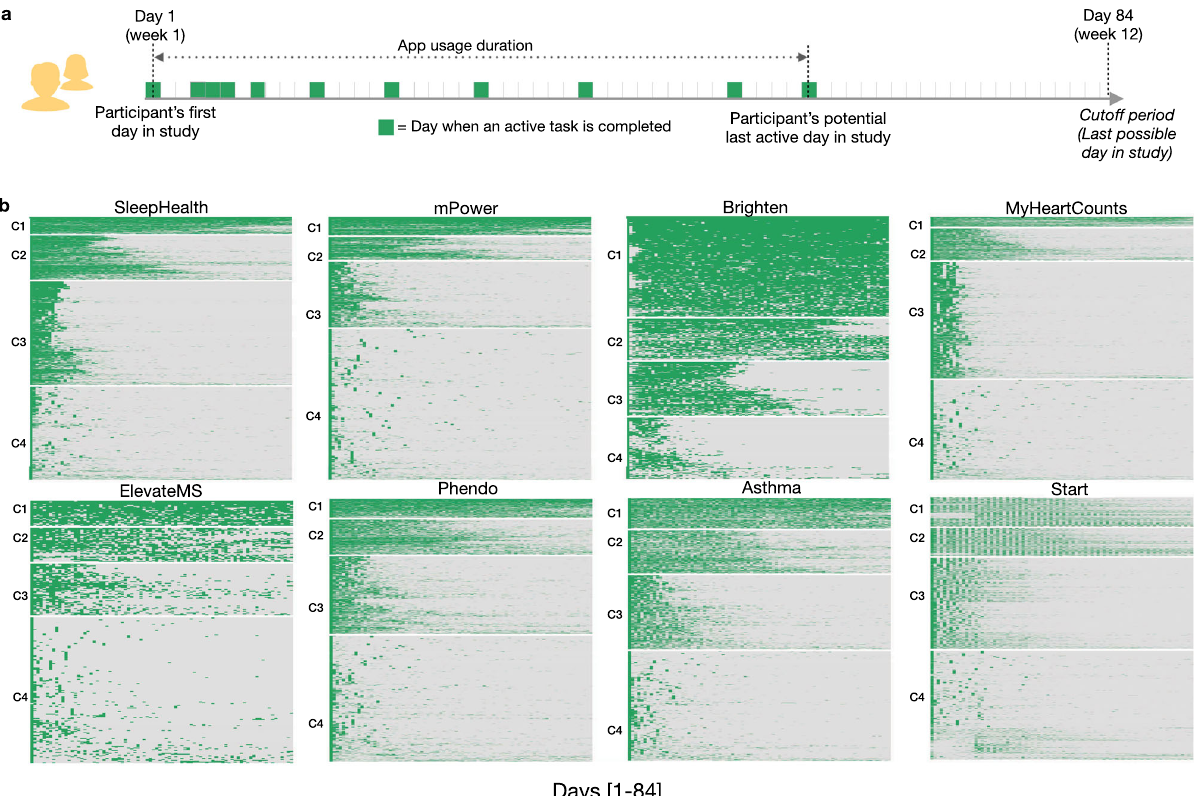
Fig. 3 Daily participant engagement patterns in digital health studies. a Schematic representation of an individual ’ s in-app activity for the fi rst 84 days. The participant app usage time is determined based on the number of days between the fi rst and last day they perform an active task(indicated by the green box) in the app. Days active in the study is the total number of days a participant performs at least one active task (indicated by the number of green boxes). b Heatmaps showing participants in-app activity across the apps for the fi rst 12 weeks (84 days), grouped into four broad clusters using unsupervised k-means clustering. The optimum number of clusters was determined by minimizing the within-cluster variation across different cluster sizes between 1 – 10. Seven out of eight studies indicated four clusters to be an optimum number using the elbow method. The heatmaps are arranged by the highest (C1) to the lowest user-engagement cluster